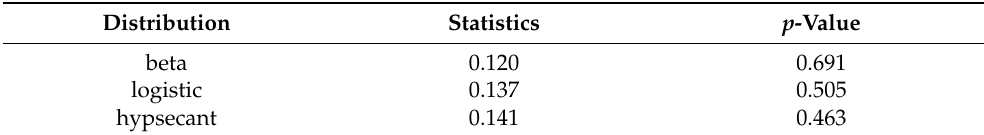
Table 3. Top three distributions to fit the Provisional Counts of Death Dataset. Distribution